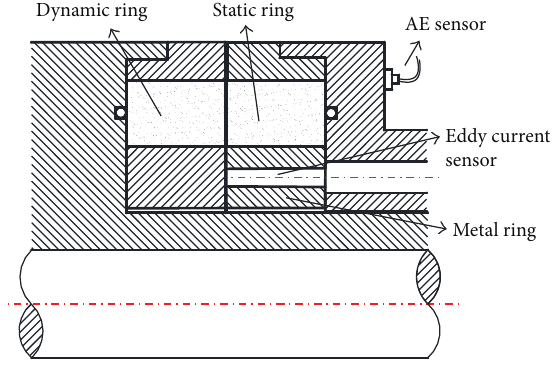
Figure 1: Sensors installation.